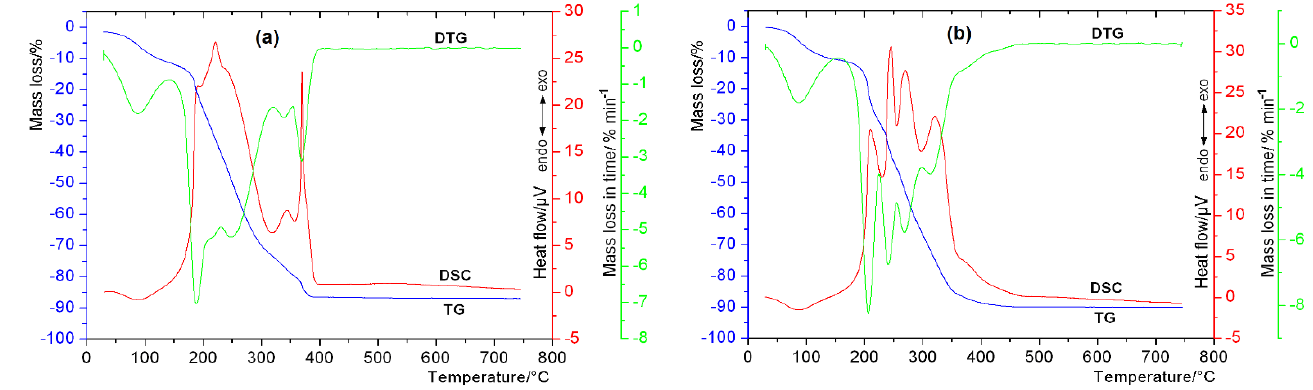
Figure 3. TG − DTG − DSC thermal curves for Fe(III) ( a ) and Cu(II) ( b ) chlorogenates. Table 1. Results of thermal decomposition of Cu(II) and Fe(III) 5-CQAs in air atmosphere. Complex